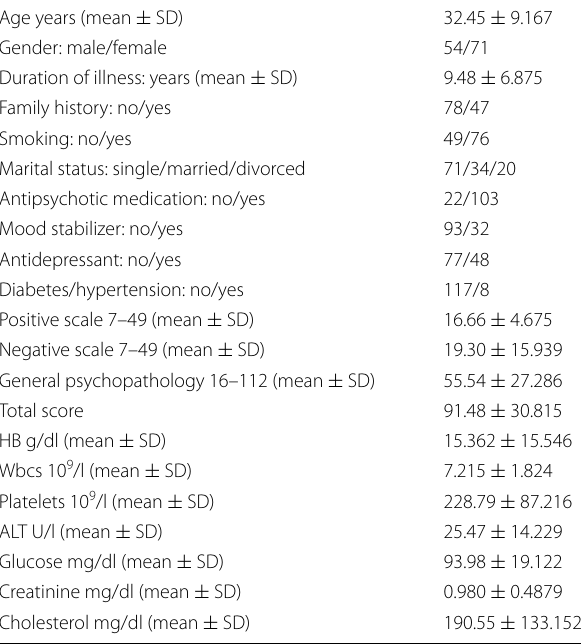
Table 2 Demographic, clinical, and laboratory